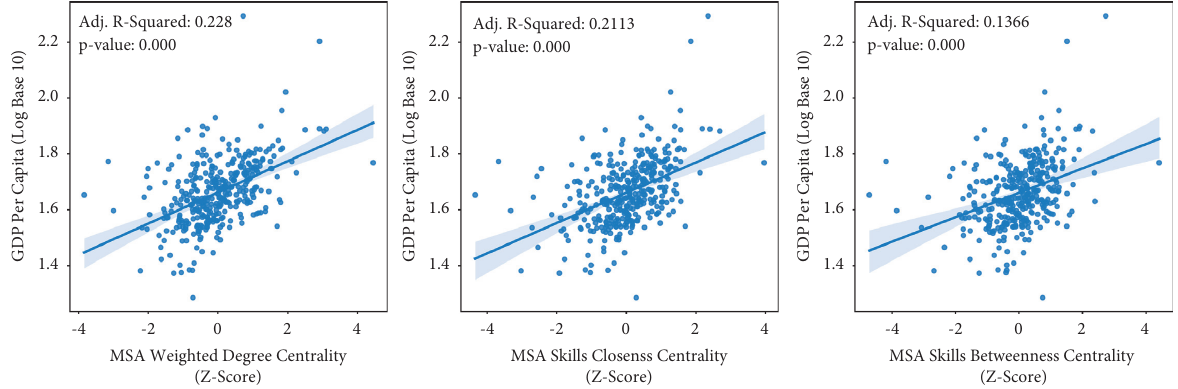
Figure 6: MSA skill centrality versus regional